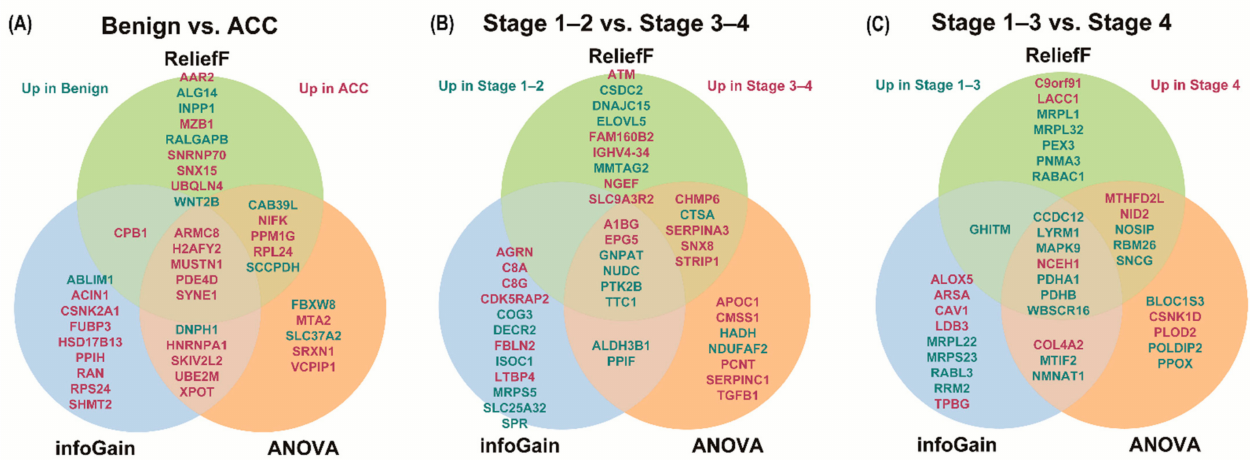
Figure 3. Feature selection of proteins for classification (top 20 DEPs). Feature selection was performed using ReliefF, infoGain, and ANOVA for DEP. Using each algorithm, the top 20 DEPs were obtained, and proteins with high rankings in all algorithms are displayed in overlapping circles. Differential expressions of proteins in ( A ) benign adrenal adenomas and ACC, ( B ) stages 1–2 and 3–4 ACCs, and ( C ) stages 1–3 and 4 ACCs are expressed, respectively. Red letters indicate highly expressed proteins in the worse group, while green letters indicate highly expressed proteins in the better